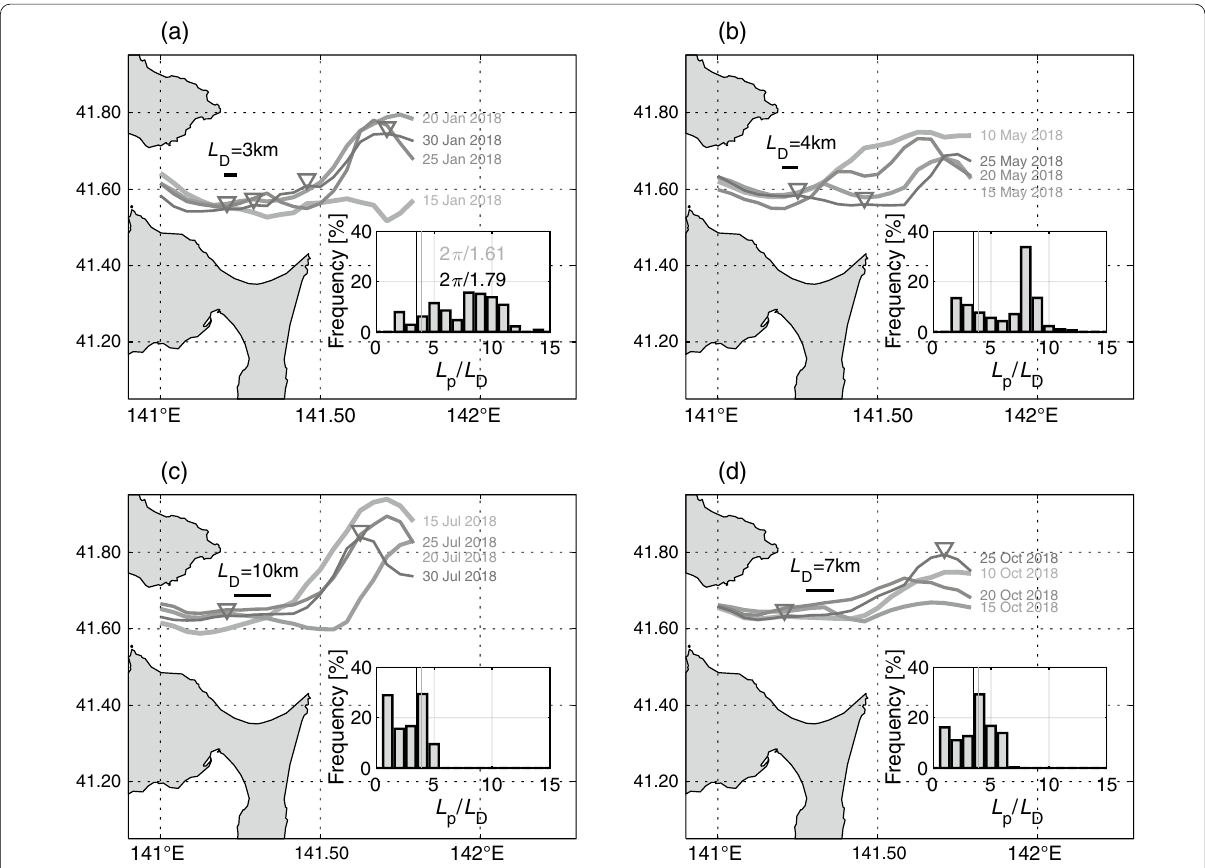
Fig. 9 Examples of shorter-term variation in the axis of the Tsugaru Warm Current estimated from the high-frequency radar during a winter, b spring, c summer, and d autumn. The thick–light (thin–dark) lines denote earlier (later) dates. The frequency distribution of the ratio of the zonal scale of adjacent meandering peaks ( L p ) to the internal deformation radius ( L D ) for each season is shown in the